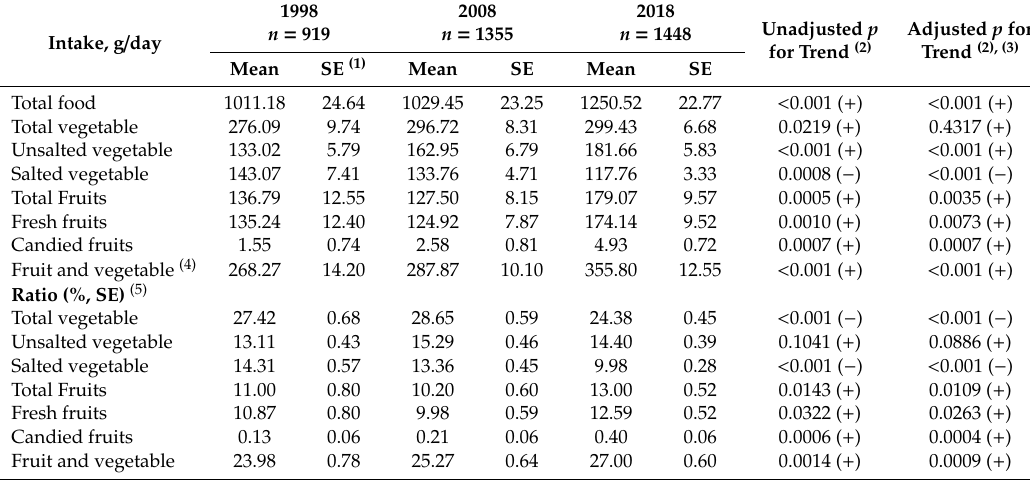
Table 1. Intake of Fruit and Vegetable according to survey